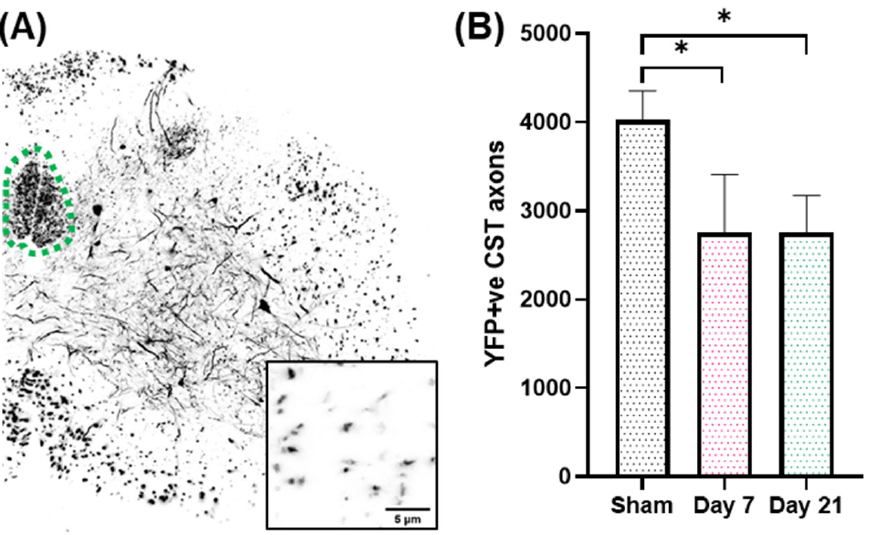
Figure 1. ( A ). Lower cervical spinal cord section showing YFP(+) axons and neurons. The dorsal corticospinal tract is traced with a green dotted line. Inset shows individual CST axons at higher magnification. ( B ). Loss of YFP(+) axons in the CST after single IA-TBI. *, p <